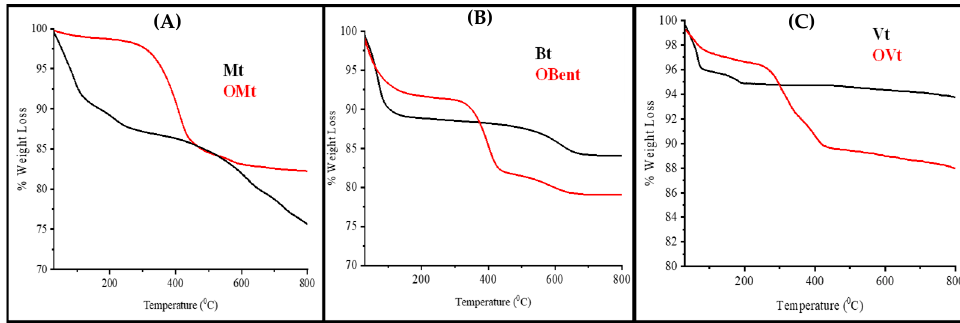
Figure 5. Thermogravimetric analysis (TGA curve) of ( A ) Mt, OMt, ( B ) Bent, OBent and ( C ) Vt, OVt.